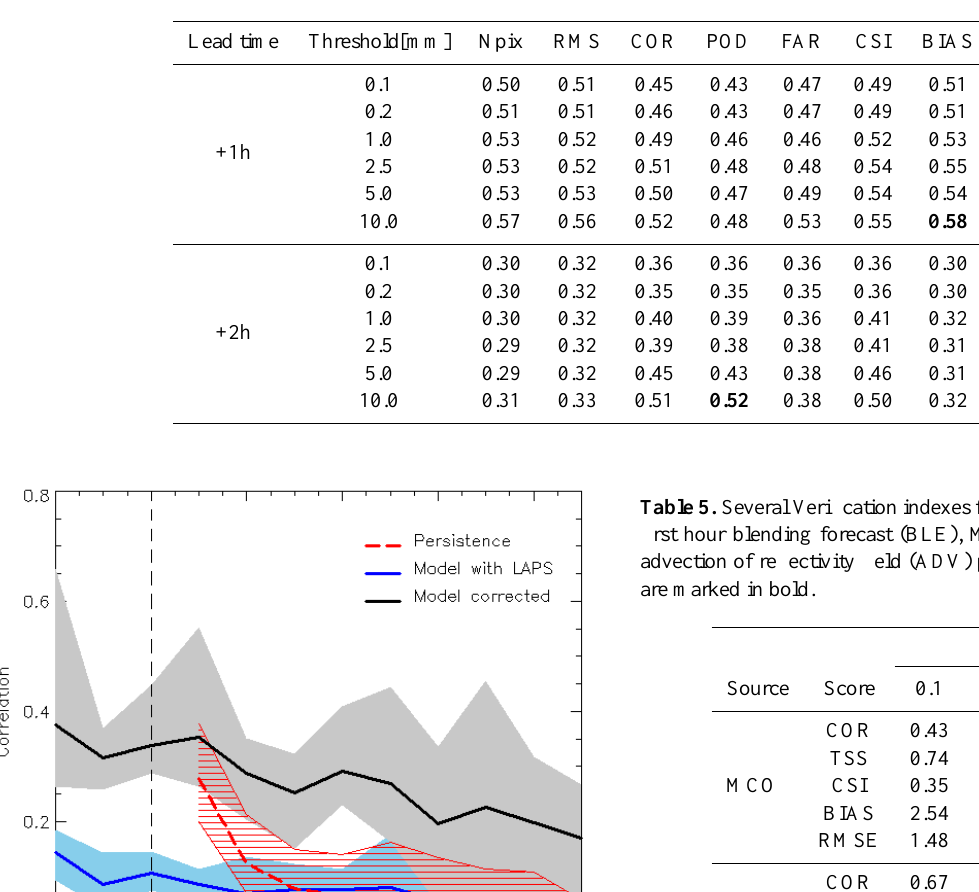
Table 4. Correlation between the blending and observation rainfall field in the first hour (upper) and second hour (lower), where the blending is constructed by the index given in the first row and the threshold written in the second column. Best result for each lead time is marked in bold type.